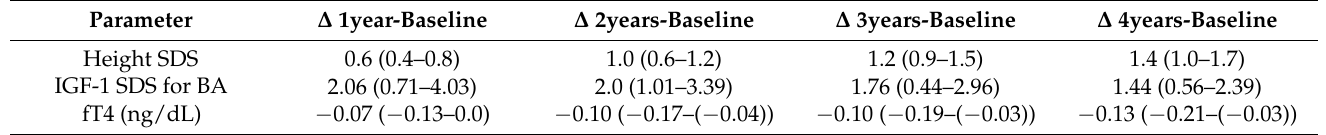
Table 2. Characteristics of changes ( ∆ ) in height SDS, IGF-1 SDS and fT4 values after the initiation of rhGH therapy. Parameter ∆ 1year-Baseline ∆ 2years-Baseline ∆